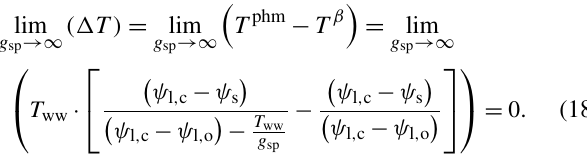
Figure 2. Fundamental differences between minimalist PHM and β . (a–b) , Supply (red) and demand (black) curves for PHM ( a , solid lines) and β ( b , dashed lines) under varying leaf water potentials ( ψ l ). The squares (circles) represent the PHM ( β ) solution – i.e., the ψ ∗ supply equals demand – for a single soil water availability ( ψ s ) and two atmospheric moisture demands ( T ww ). These markers carry through panels (c) and (d) to illustrate how the solutions between the PHM and β diverge at a single ψ s . The relative size of the markers indicates corresponding T ww . The water potential difference (cid:49)ψ required to transport water from soil to leaf is shown in panel (a) for ψ s = − 1MPa and T ww = 10mmd − 1 . (c) Solutions of panels (a) and (b) mapped to ψ s , where (cid:49)T is the difference between PHM and β transpiration estimates at ψ s = − 1MPa and T ww = 10mmd − 1 . (d) Relative transpiration, in which solutions in panel (c) are normalized by T ww . The β solutions collapse to a single curve, whereas the PHM solutions depend on T ww